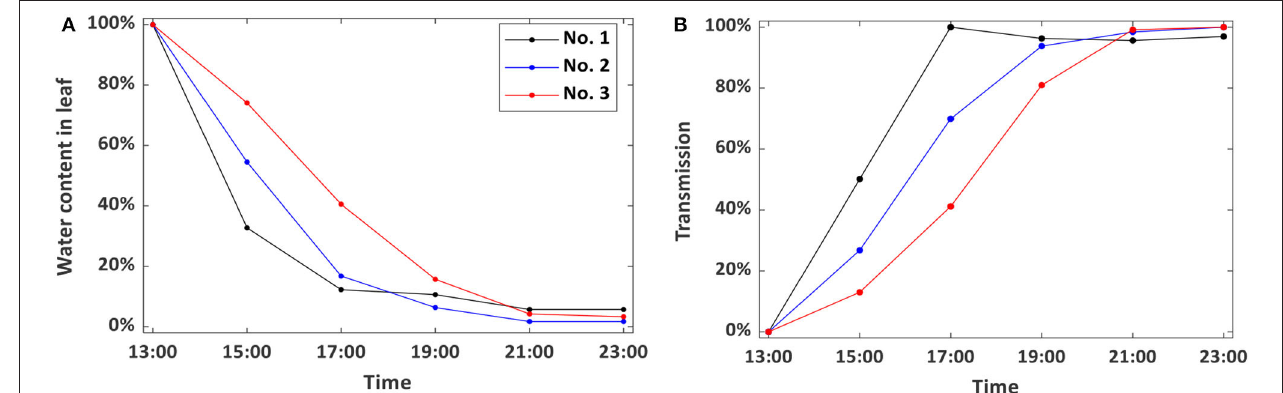
with the increasing of the dehydration time. This is due to the intercellular spaces between the mesophyll cells, which do not differentiate palisade and spongy tissues [32, 33]. These spaces allow the passage of gases and makes the water loss rate to be slow in the later dehydration time [34]. Besides, the transmitted THz signal amplitude increases gradually along the